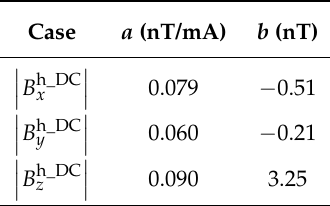
Figure 4. The amplitude of three-axis components of B h_DC ( function of the heater’s driving current ( I h ). The lines that overlay the data is a linear fitting to y = aI h + b . The fitting results are shown in Table 3. Table 3. The driving voltage, driving current, and the amplitude of three-axis magnetic field generated by the heater.